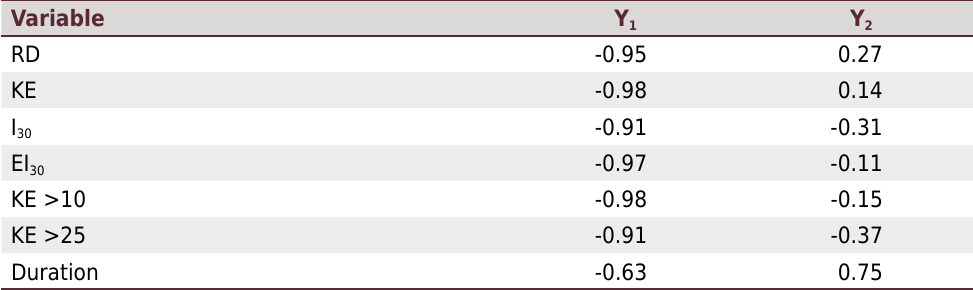
Table 3. Linear correlation coefficients between the rainfall and erosivity characteristics and the first two principal components (Y 1 and Y 2 )